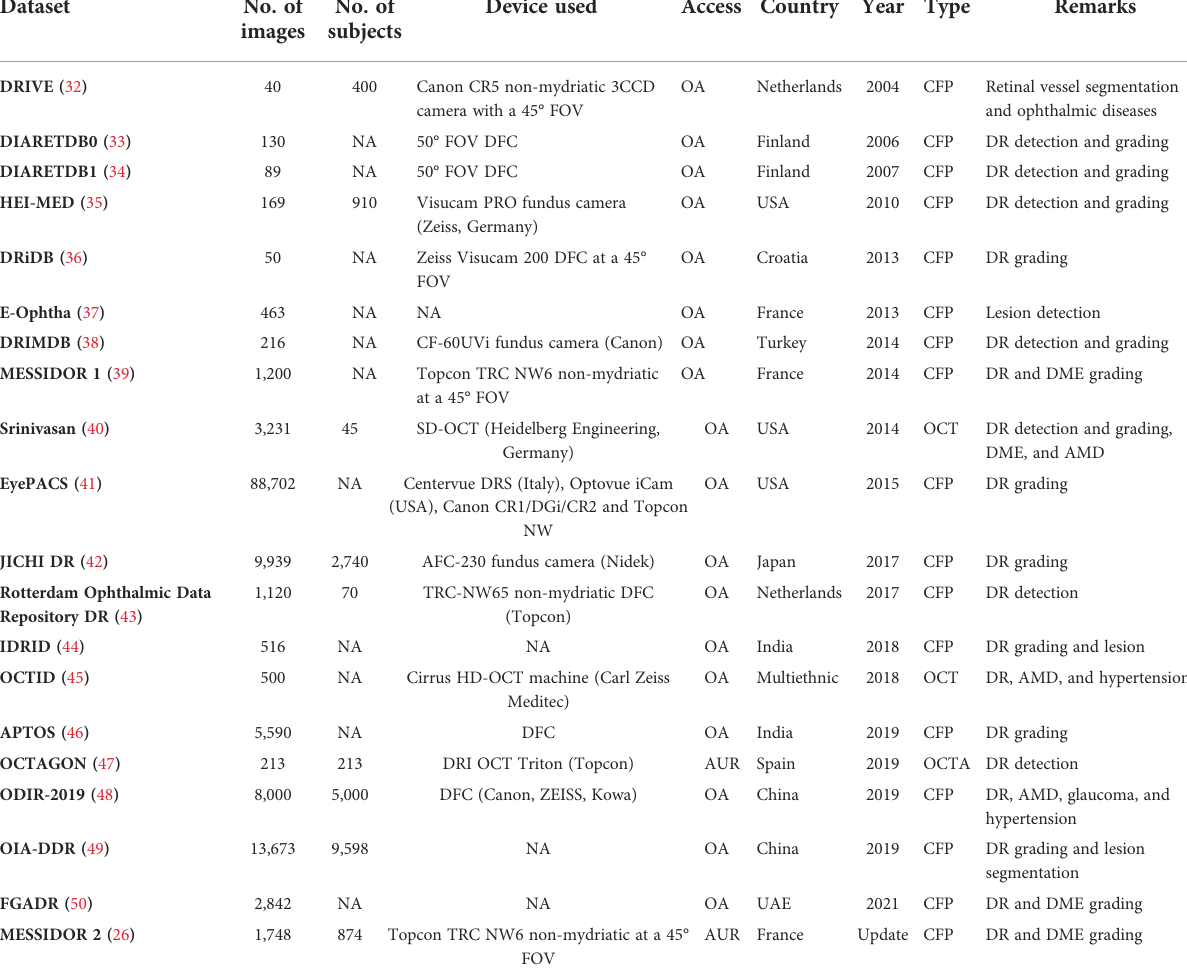
TABLE 1 Datasets for diabetic retinopathy (DR) detection, segmentation, and grading.